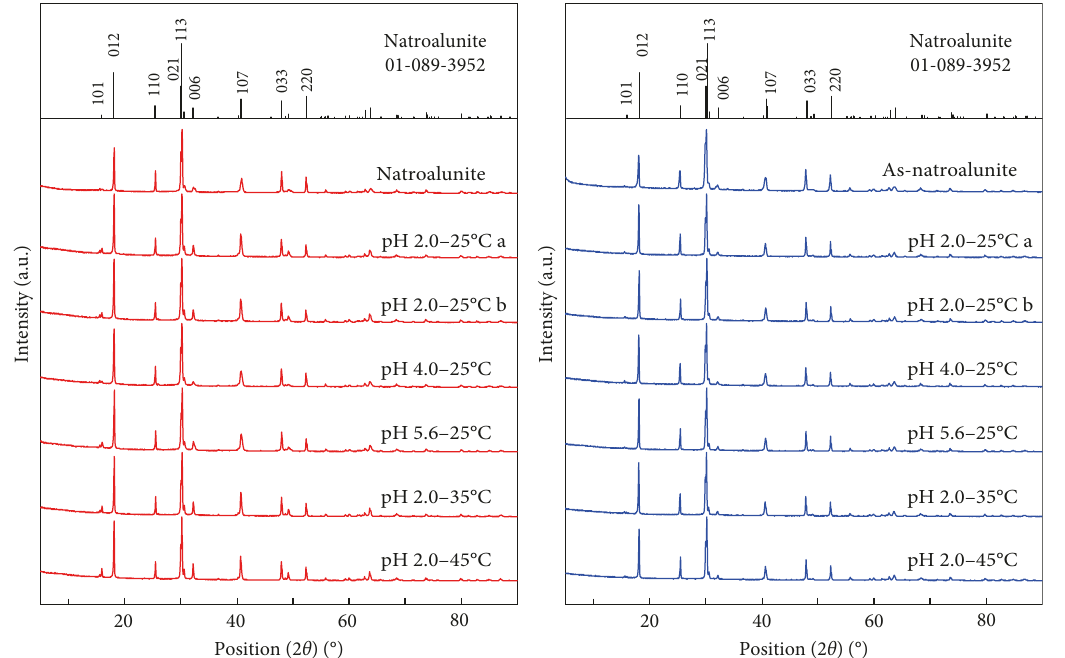
Figure 1: X-ray diffraction patterns of the synthetic natroalunite and the synthetic arsenic-incorporated natroalunite before and after dissolution at 25–45 ° C for 300d.